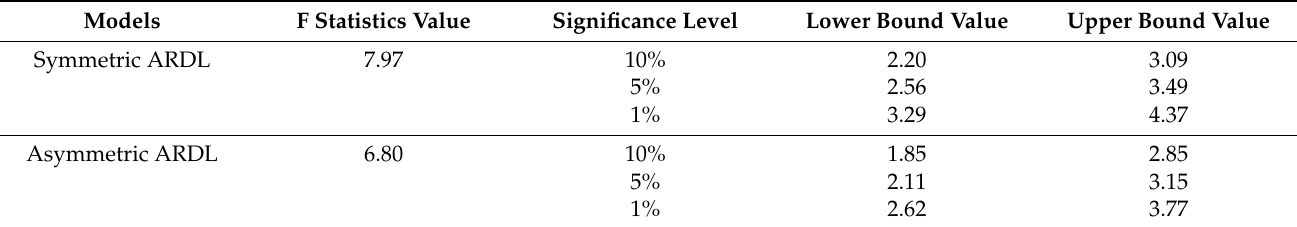
Table 4. Bound test for Symmetric and Asymmetric